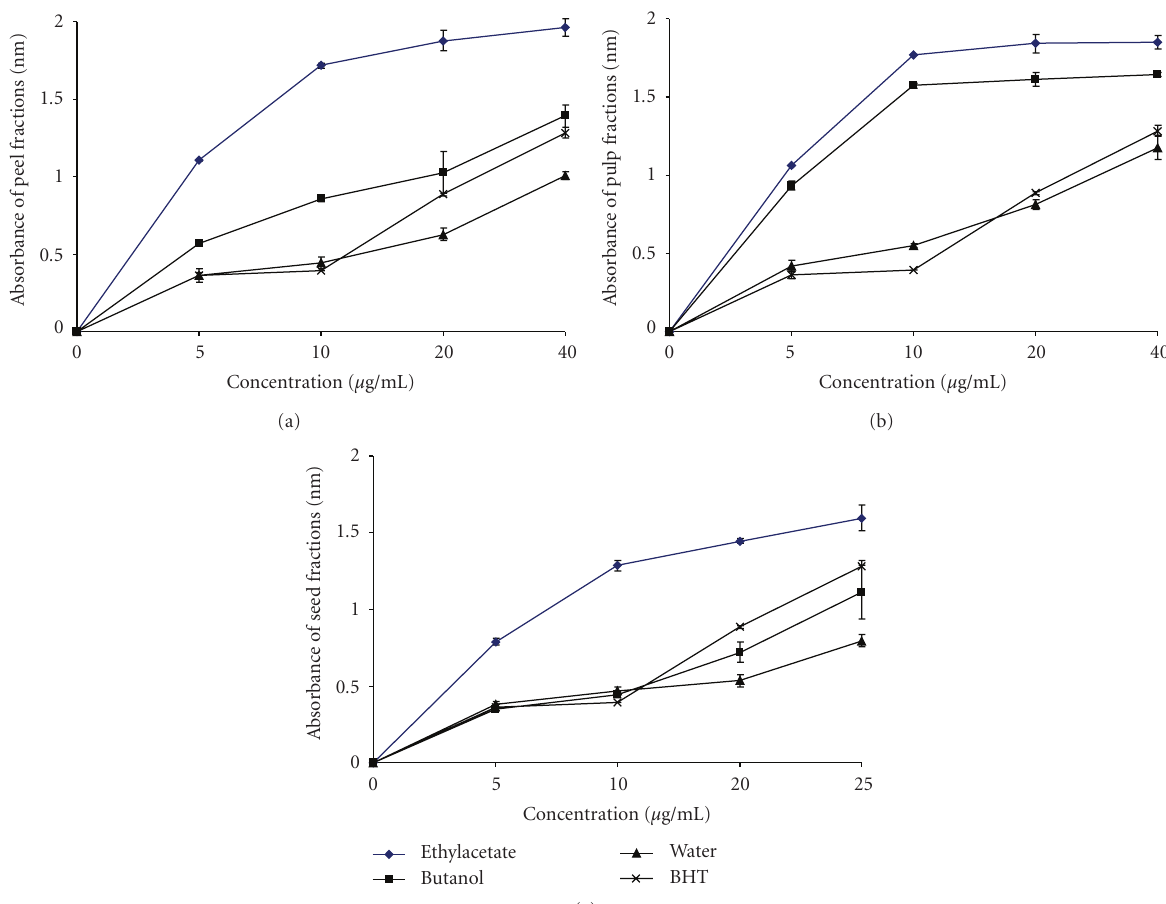
Figure 4: Reducing power of Canarium odontophyllum peel fractions (a), pulp fractions (b), and seed fractions (c). Higher absorbance value indicates higher antioxidant activity.